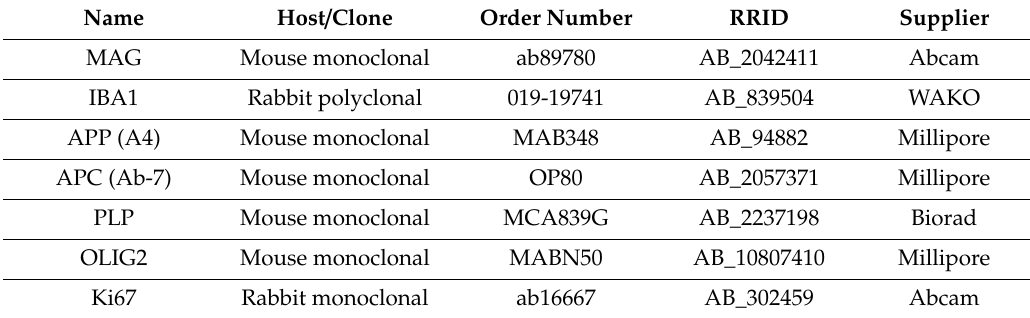
Table 1. Primary antibodies used in this study.